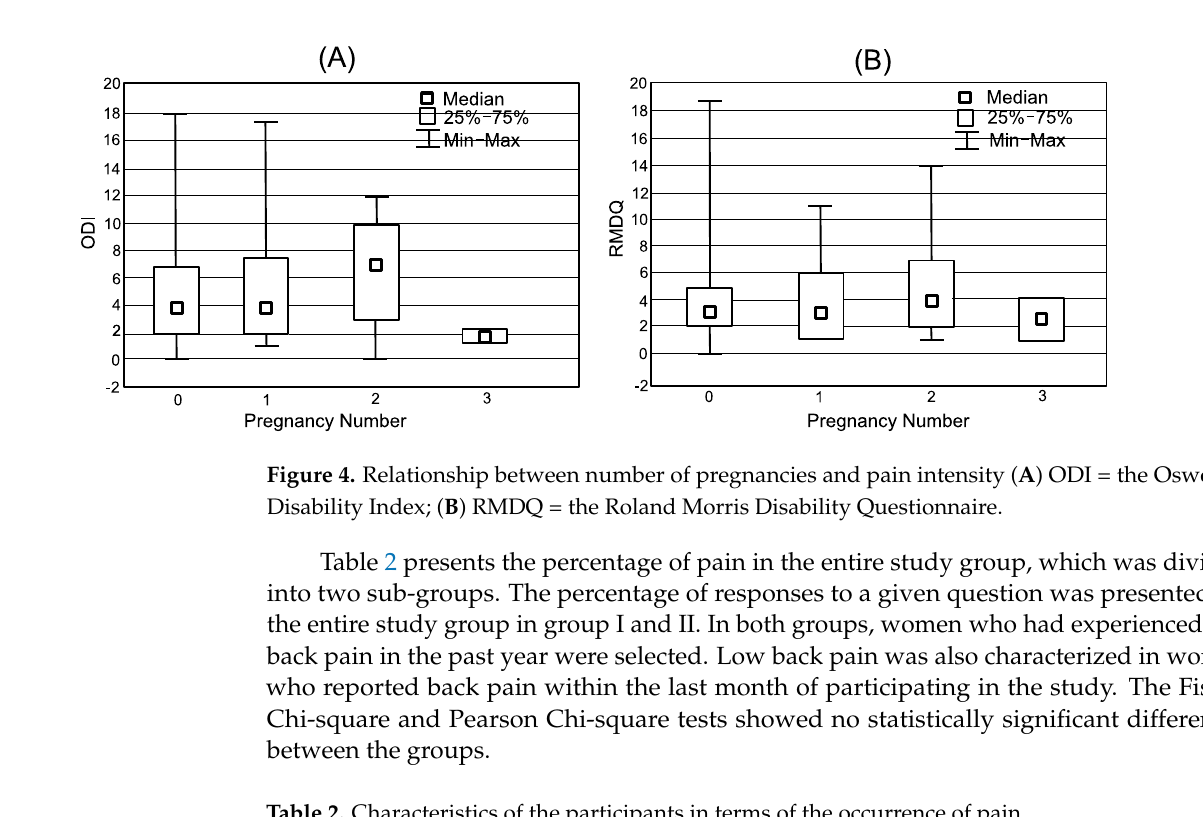
Table 2. Characteristics of the participants in terms of the occurrence of